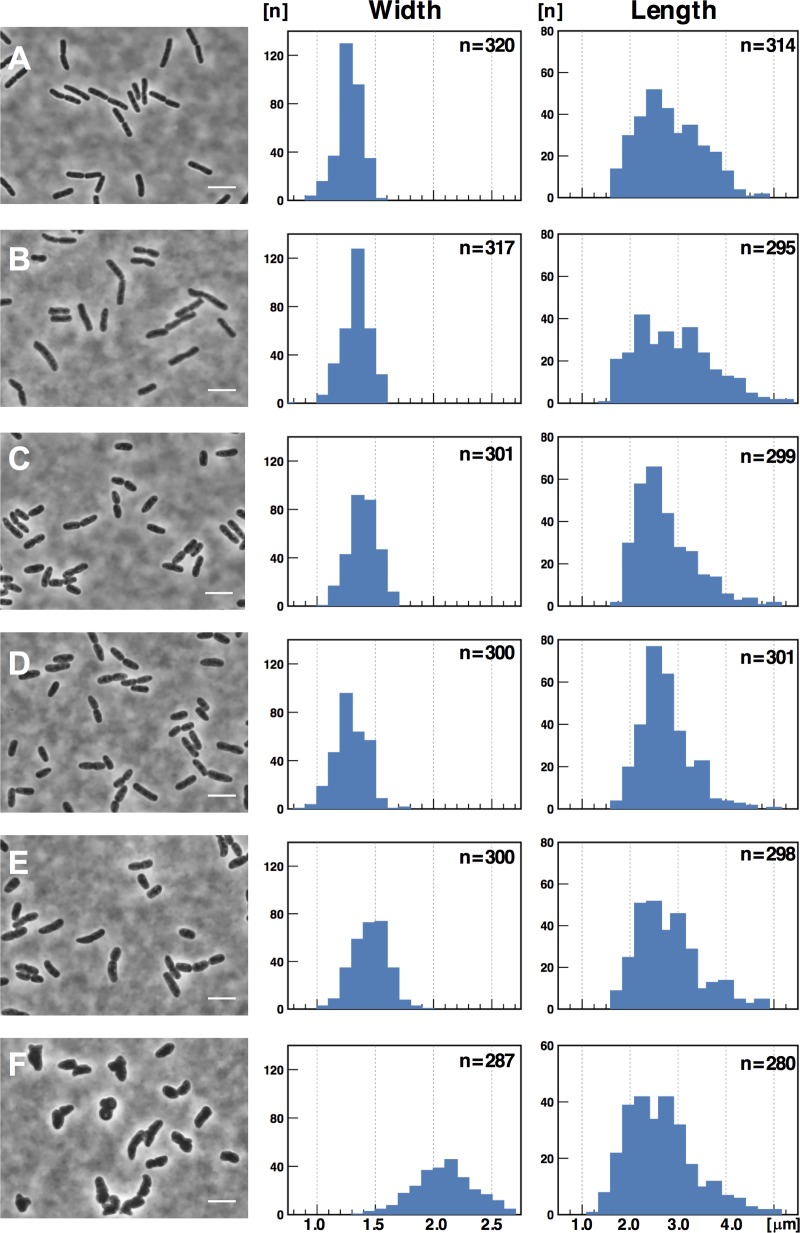
Shapes of the ΔrodZ mutant expressing RodZ cysteine-substitution mutants.(A) wild-type strain MS390. ΔrodZ strain carrying: (B) pBAD-rodZwt (MS5215); (C) pBAD-rodZC38S (MS5242); (D) pBAD-rodZC263S (MS5243); (E) pBAD-rodZC38S, C263S (MS5244); or (F) pBAD18-Kan (MS5204). Strains were grown to OD600 = 0.4 in 5-ml LB medium containing 25 μM arabinose and kanamycin at 30°C with shaking (150 rpm) for 2.5 hrs. Cells were fixed with 1.0% formaldehyde and observed using a phase-contrast microscope. Scale bar = 5 μm. The length distributions were analyzed using two tailed Student’s t test. Significance (p<0.05) differences were observed between all combinations of width and length, except for the combinations of lengths as follows: (C) and (D); (D) and (E); (C) and (E). Results are combination of three independent experiments.